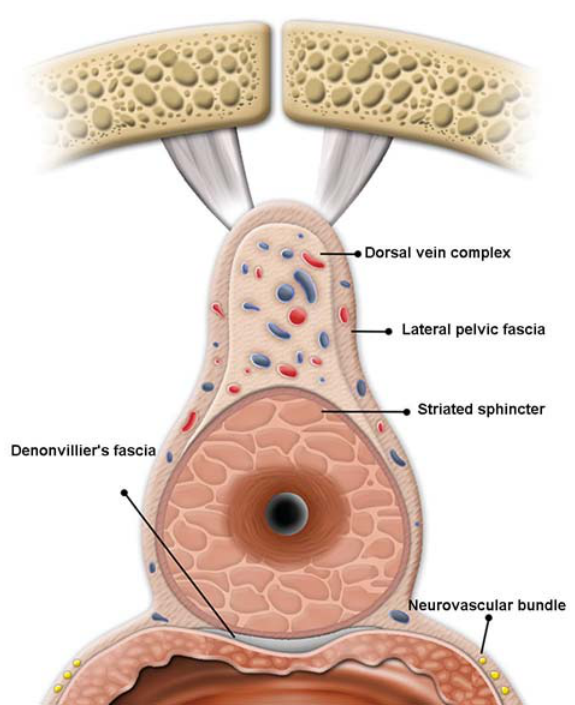
Figure 3 – Diagram showing urethra and its relations with dorsal vein complex.